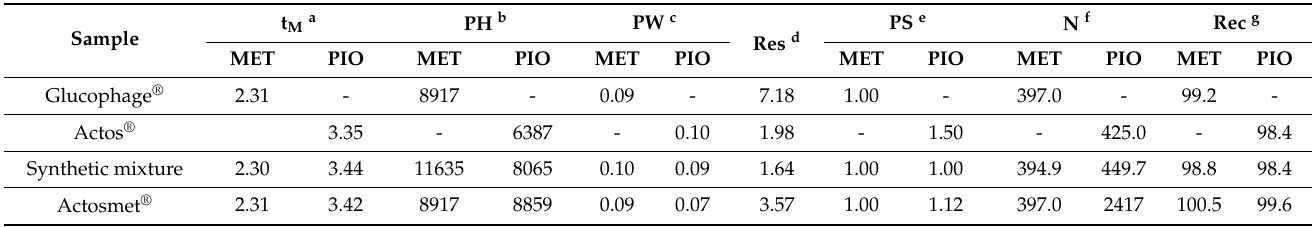
Table 3. Application of the CZE assay method for MET and PIO in pharmaceutical